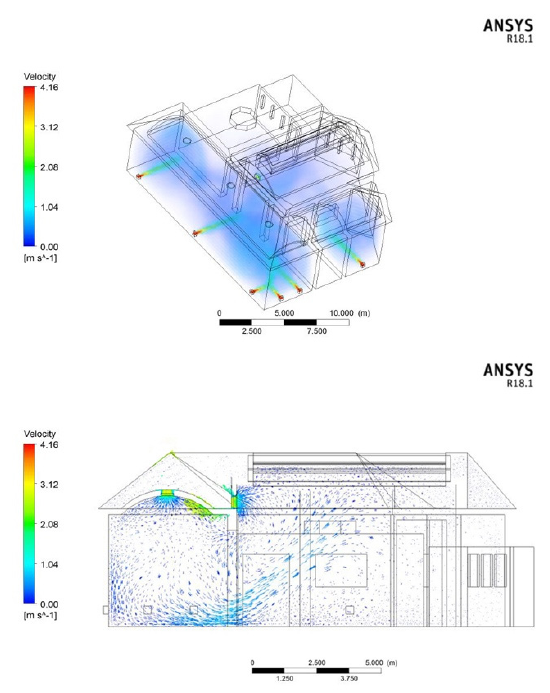
Figure 2. Computational Fluid Dynamics (CFD) simulation model Cradley Heath Library.